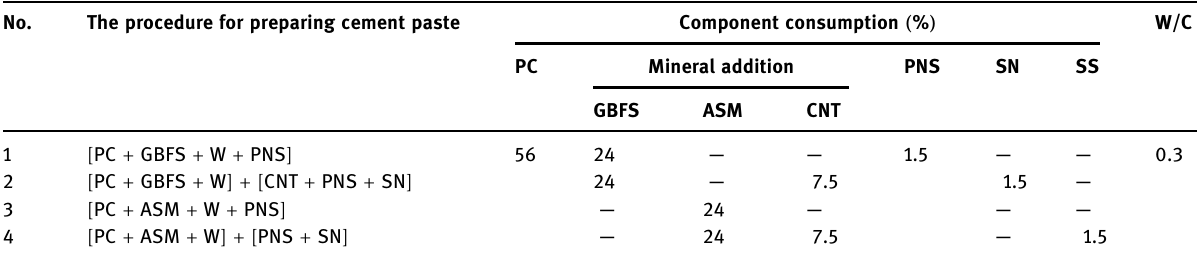
Table 9: Compositions and preparation of cement pastes No. The procedure for preparing cement paste